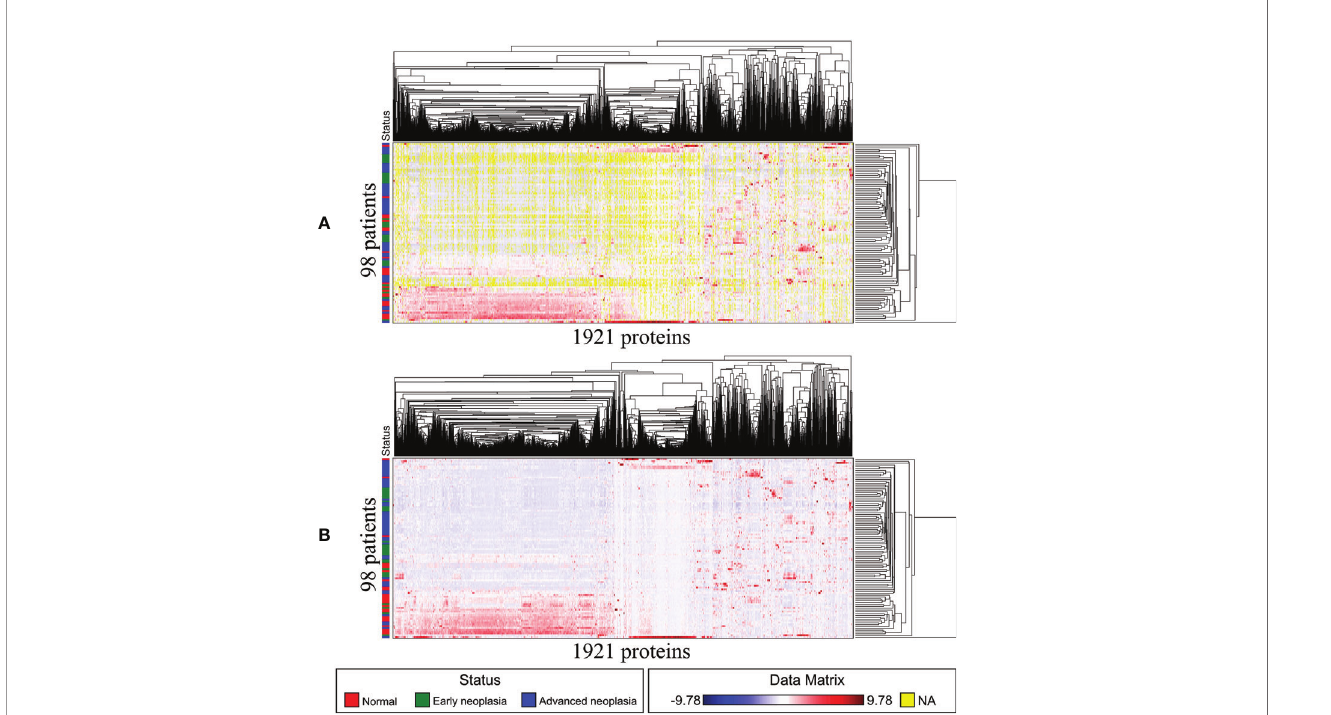
FIGURE 2 | Matrix visualization for exosome proteins also sorted by HCT – R2E seriations: 98 patients by 1921 proteins. The Euclidean distance map for 98 patients and the Pearson correlation map for 1921 proteins are not shown due to space limitations. (A) Matrix visualization before imputation. (B) Matrix visualization after